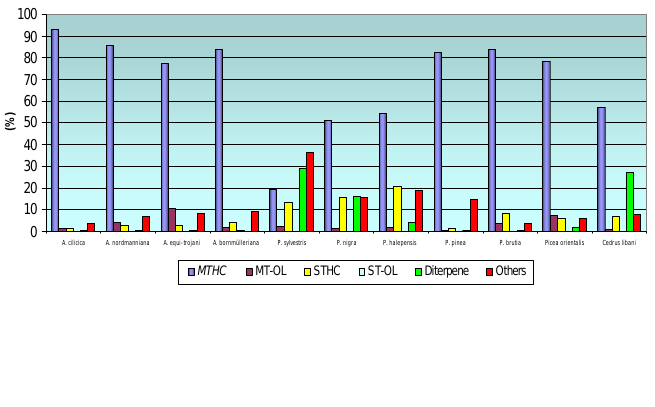
Figure 3. Terpene groups of Pinaceae Family Native Grown in Turkey (%).